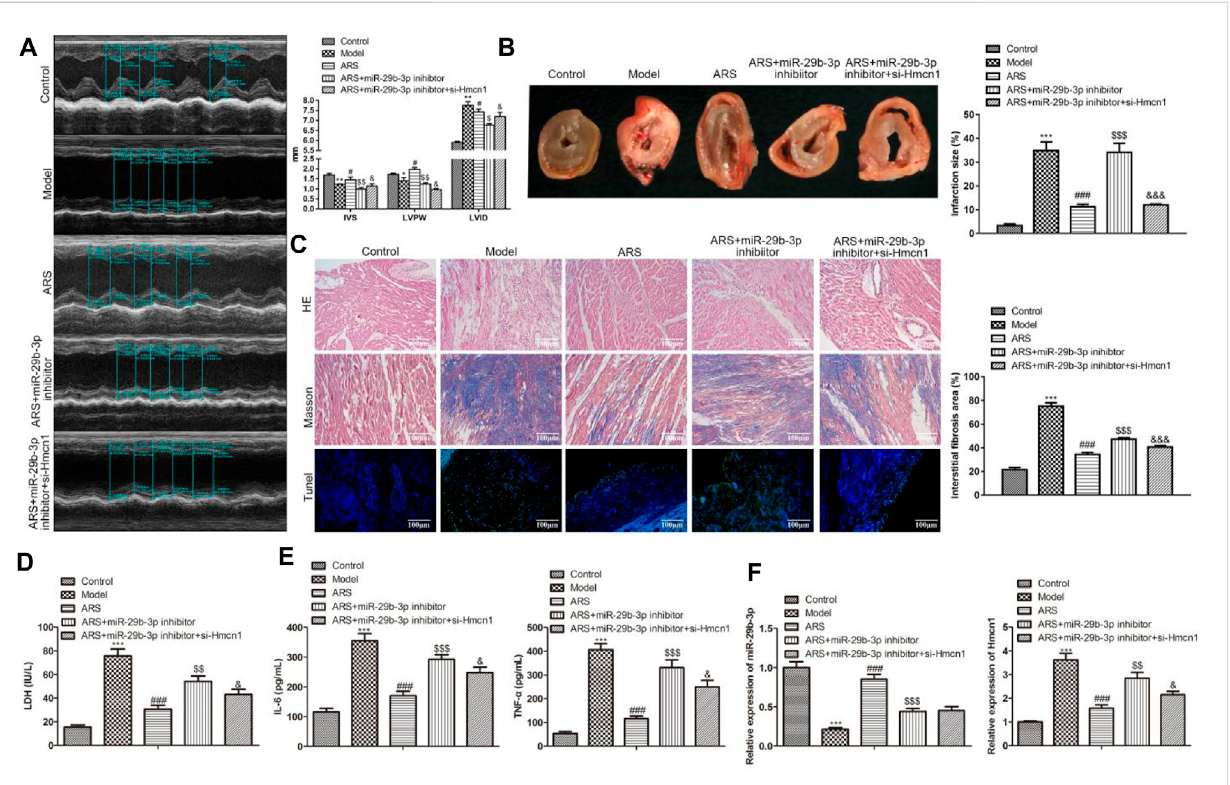
FIGURE 6 ARS suppresses myocardial I/R injury through regulating miR-29b-3p/HMCN1 in